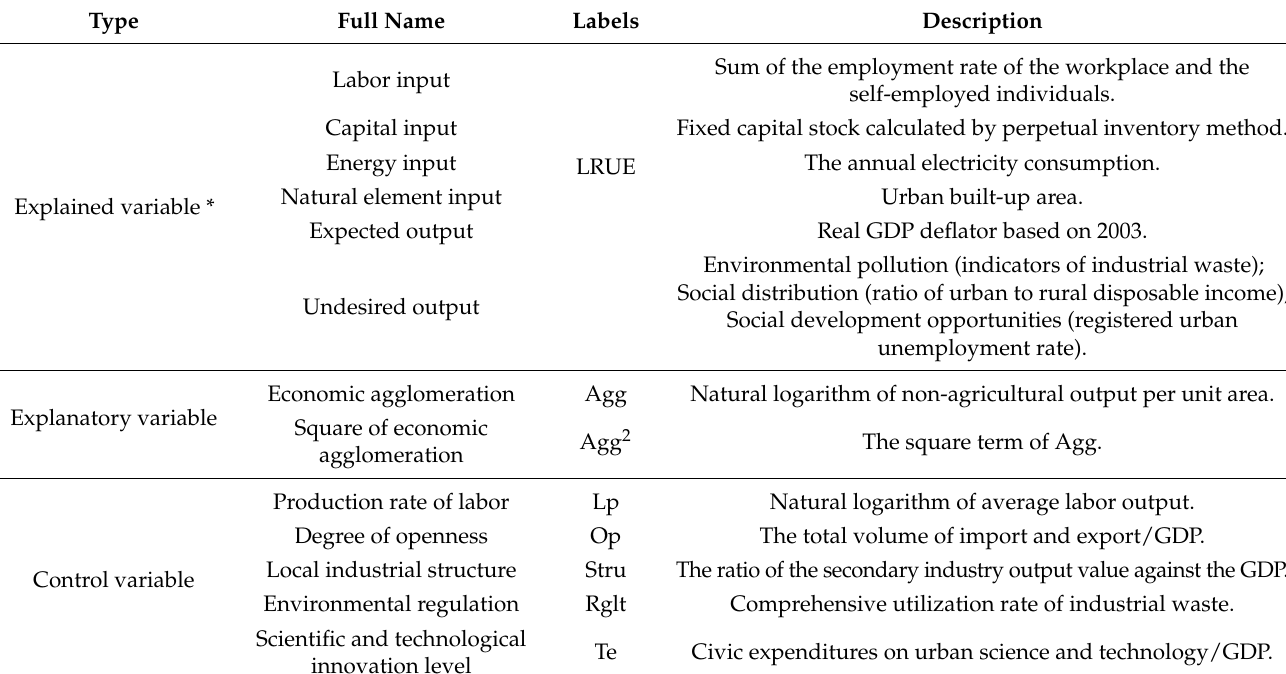
Table 1. Description of all variables in the econometric